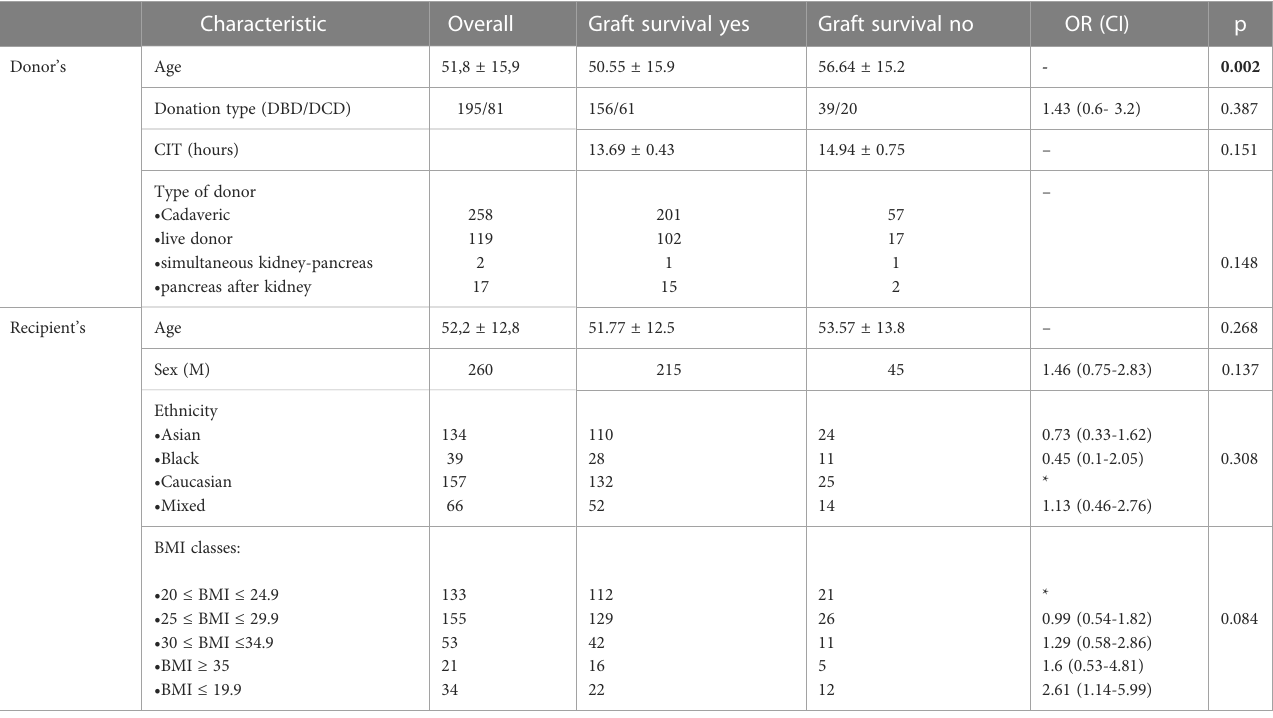
TABLE 1 Donor ’ s and recipient ’ s demographic characteristics.